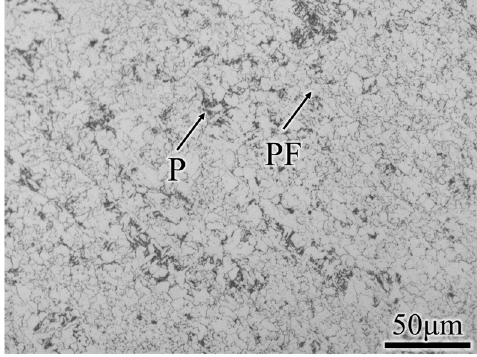
Figure 1. Optical microstructure of X65 pipeline steel.